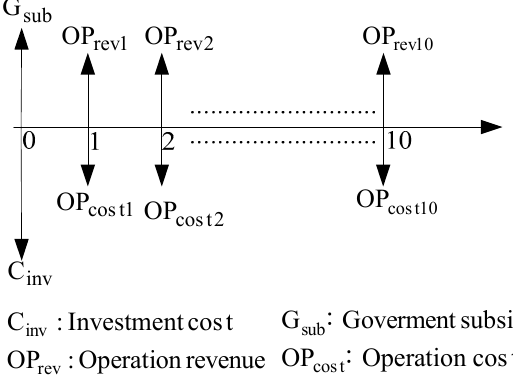
Figure 7. Cash flow for the EB charging station.